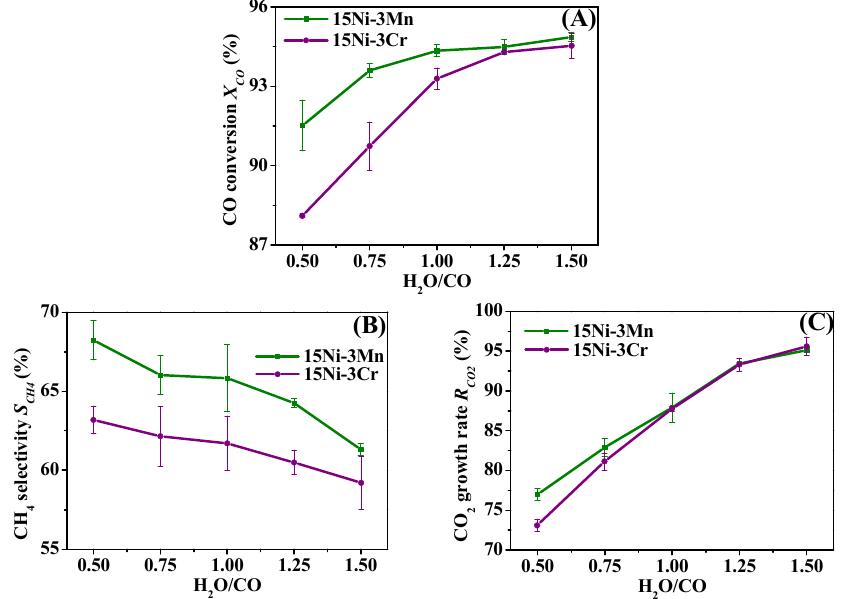
Figure 8. Effect of H 2 O/CO on partial methanation coupling with WGS at 350 °C and H 2 /CO = 0.8: ( A ) CO conversion; ( B ) CH 4 selectivity; and ( C ) CO 2 growth rate.